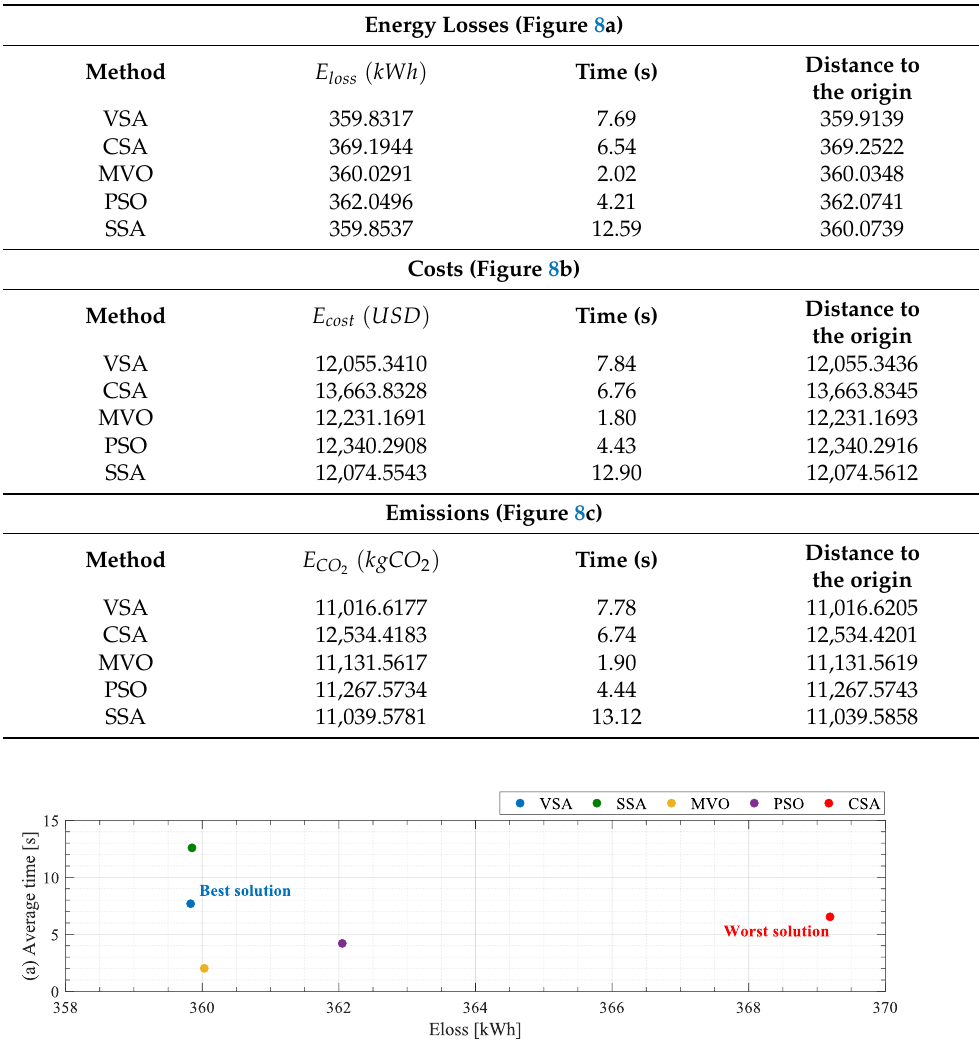
Table 10. Average objective function solution vs. average processing time in standalone system.